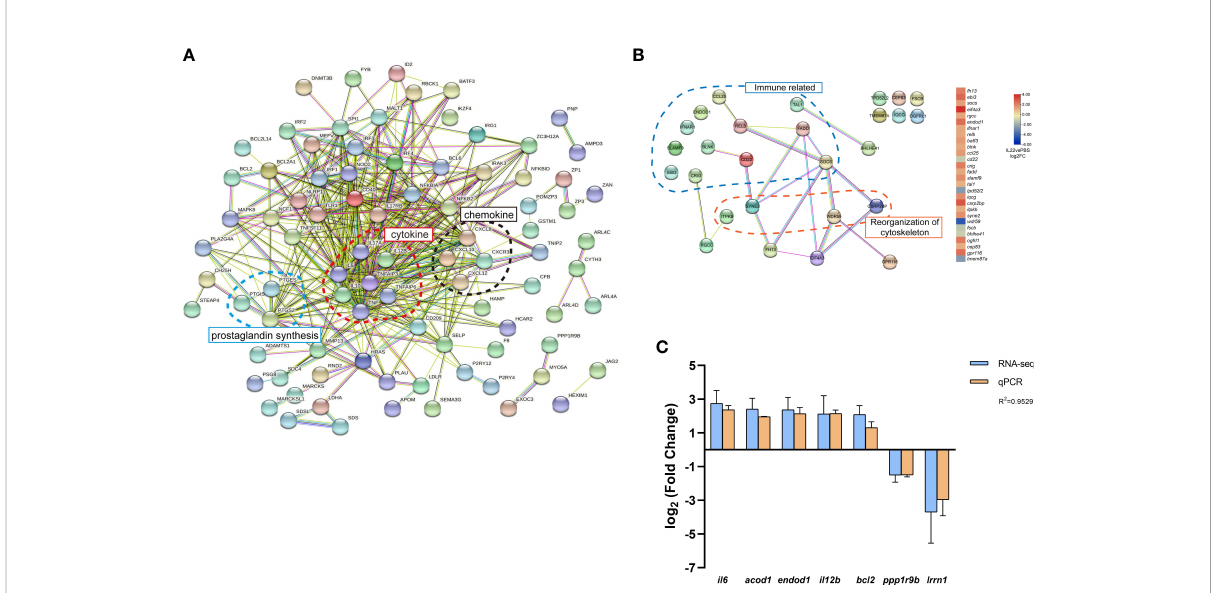
FIGURE 6 (A) The PPI analysis of the 134 DEGs enriched from the intersection of LPS vs. PBS group and IL-22 vs. PBS group. Red circle represented DEGs related to cytokine. Black circle represented DEGs related to chemokine. Blue circle represented DEGs related to prostaglandin synthesis. (B) The PPI analysis of the 34 DEGs only expressed in IL-22 vs. PBS group. Red circle represented DEGs related to reorganization of cytoskeleton. Blue circle represented DEGs related to immune related. (C) The qPCR validation of seven DEGs generated from the